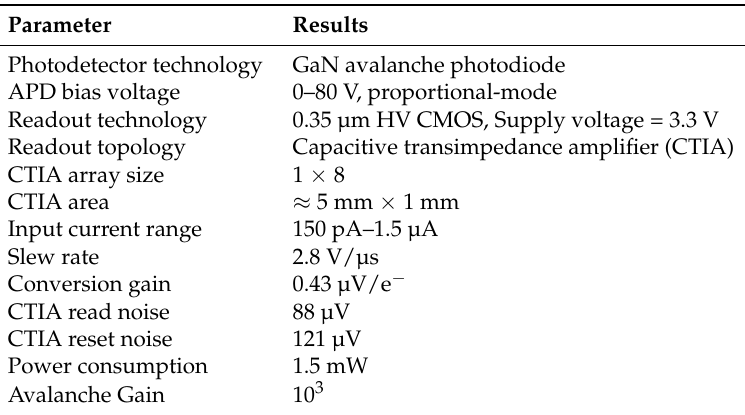
Table 1. Performance